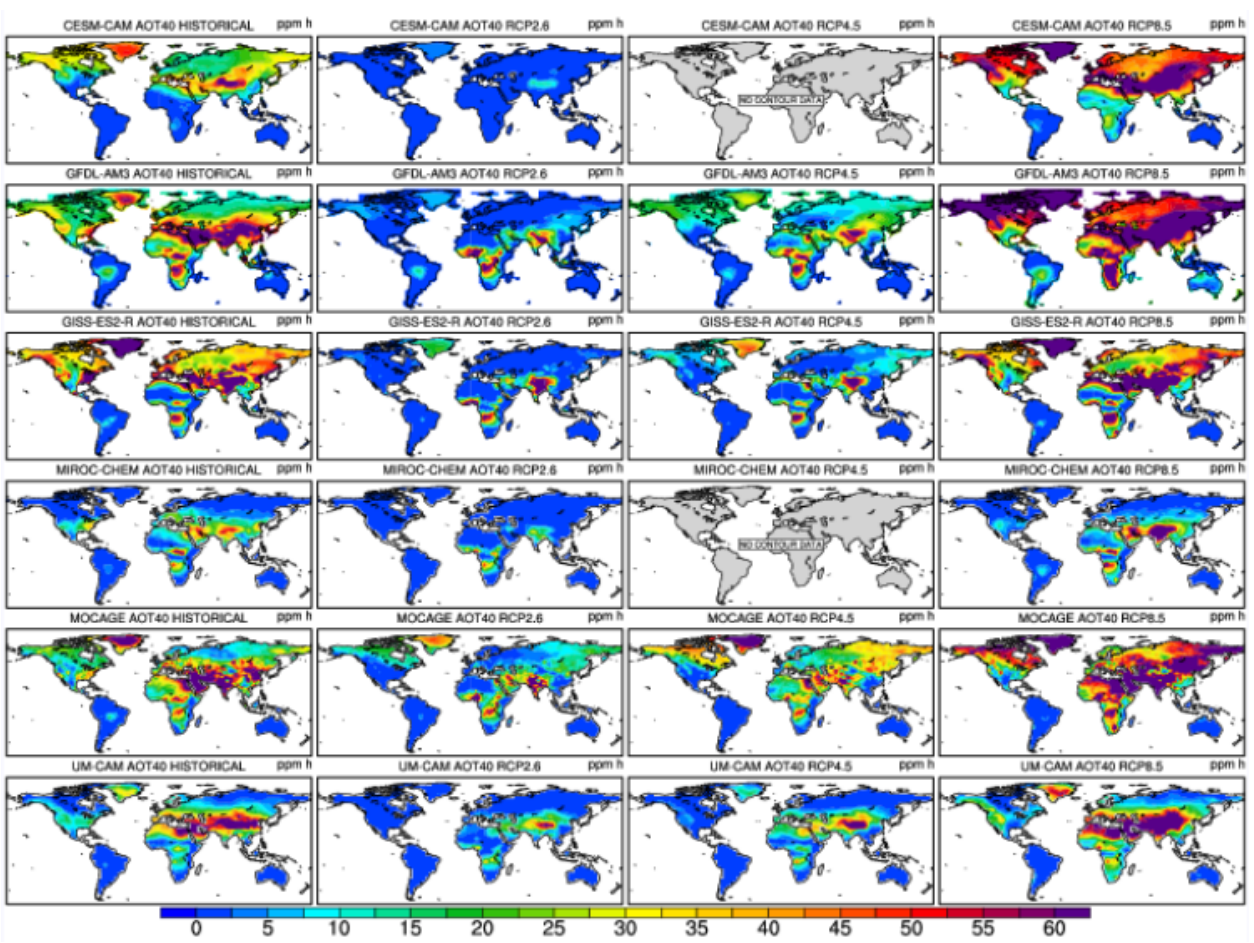
Figure 2. Surface mean AOT40 (in ppmh) at the lower model layer for each ACCMIP model over the historical period and for RCP2.6, RCP4.5 and RCP8.5 simulations by 2100. The data are missing for two models under RCP4.5 (“no contour